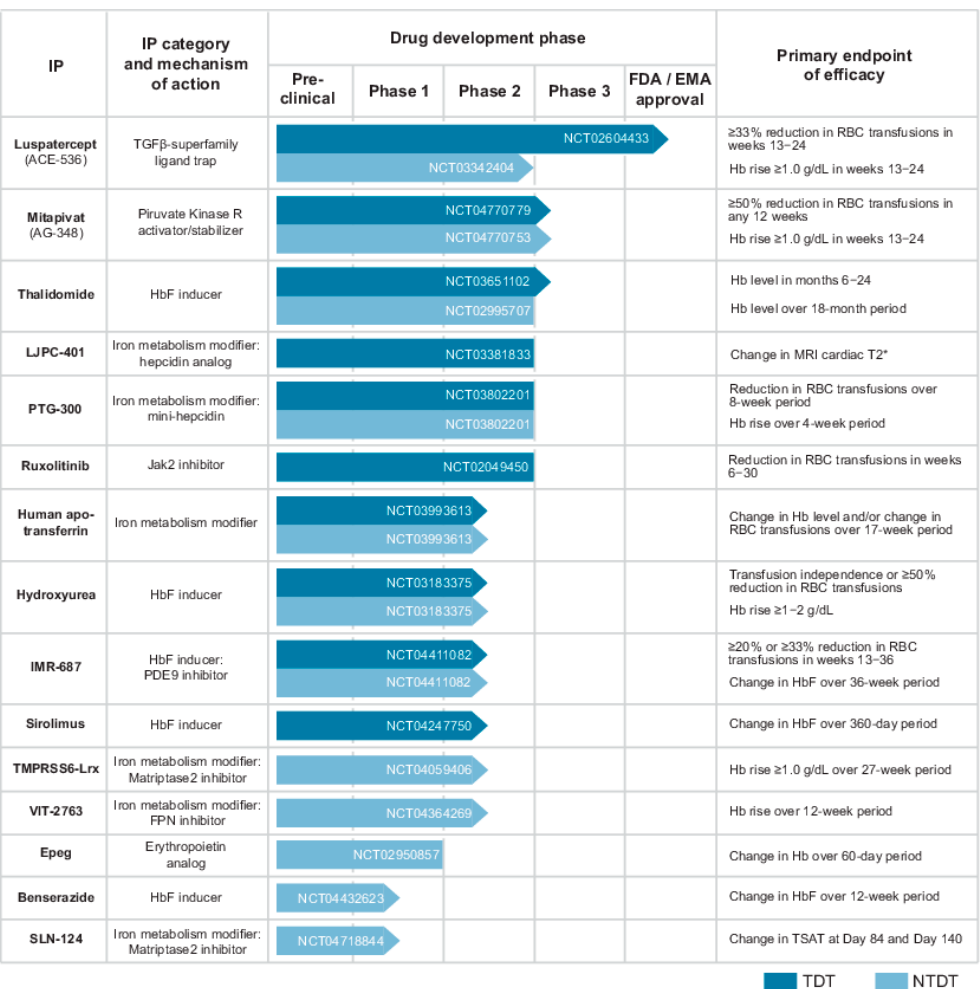
Figure 2. Development phase of investigational products (IP) that have been under clinical trial for the treatment of ineffective erythropoiesis in transfusion-dependent β -thalassaemia (TDT) or non-transfusion-dependent β -thalassaemia (NTDT), as registered on clinicaltrials.gov in the period 1 June 2016–31 May 2021. The identifier of the most recent trial is reported into the correspondent bar for each compound. Arrowed bar indicates an ongoing trial. FDA: U.S. Food and Drug Administration. EMA: European Medicines Agency.